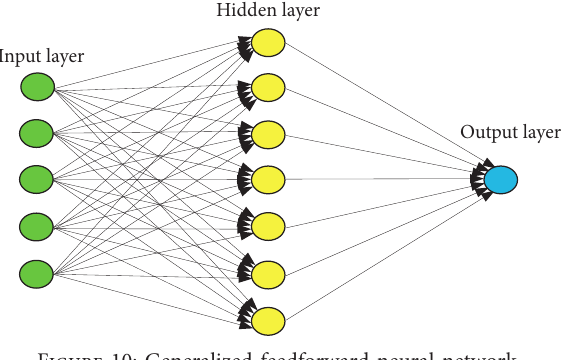
Figure 10: Generalized feedforward neural network.